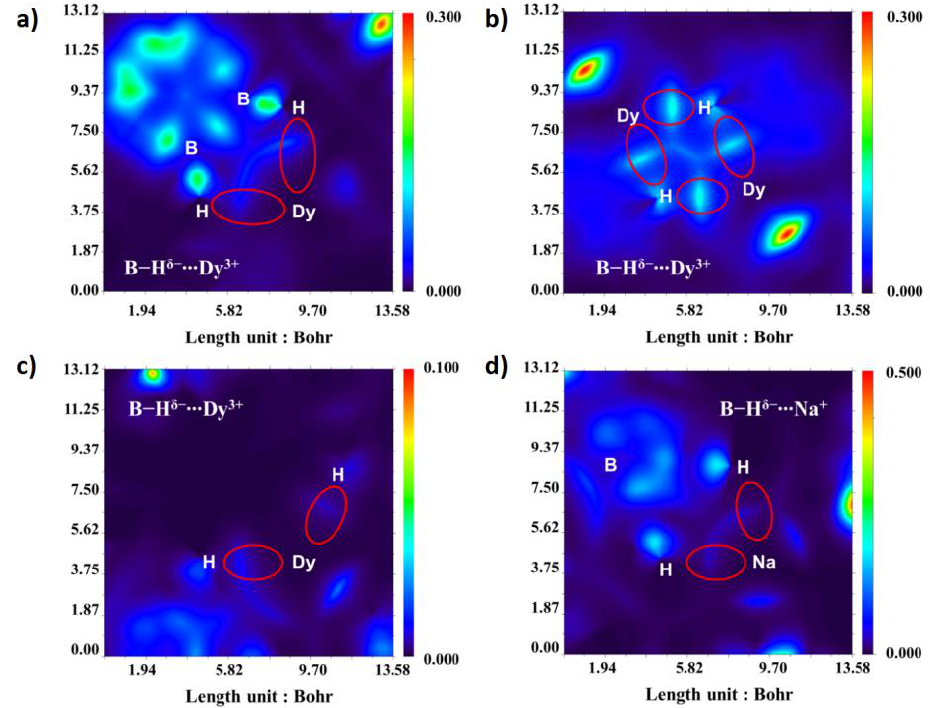
Figure 13. Cross-section coloring maps based on electron density (ED) for lanthanacarborane dimers. The red circles represent the distribution of IHBs. ( a – c ) B-H δ − . . . Dy 3+ interactions in 2Dy and 4Dy ; ( d ) B-H δ − . . . Na + interactions in 6Dy .